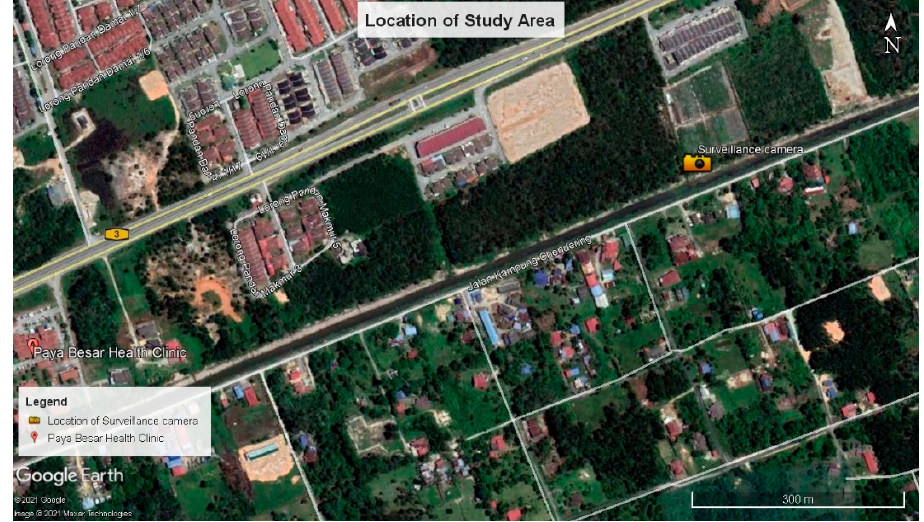
Figure 4. The yellow camera icon represents the location of the surveillance camera that was used for water detection using semantic segmentation (Image courtesy: Google Earth). for water detection using semantic segmentation (Image courtesy: Google